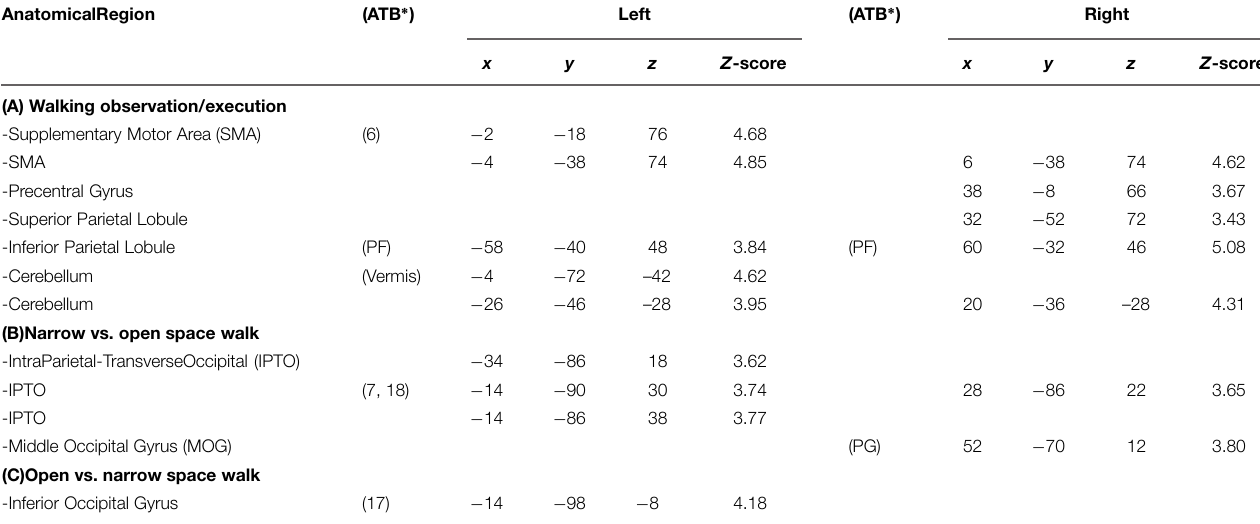
TABLE 1 | MNI coordinates of local maxima of the activation foci (conjunction null